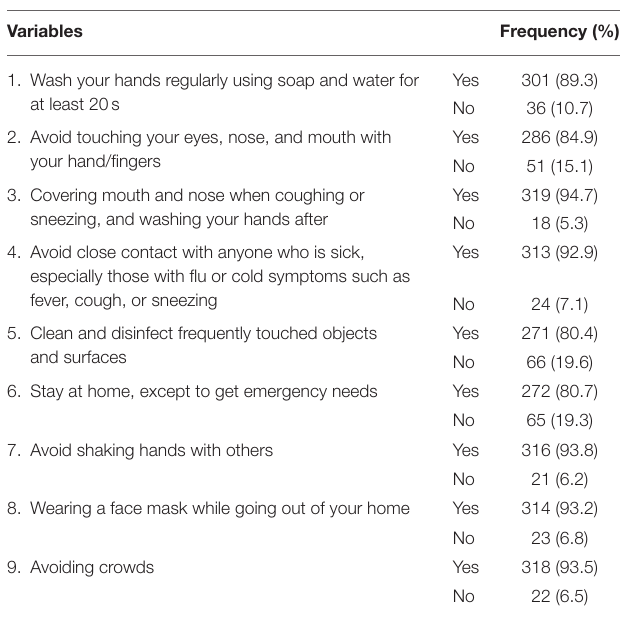
TABLE 3 | Measures taken for the prevention of COVID-19 among the participants. Variables